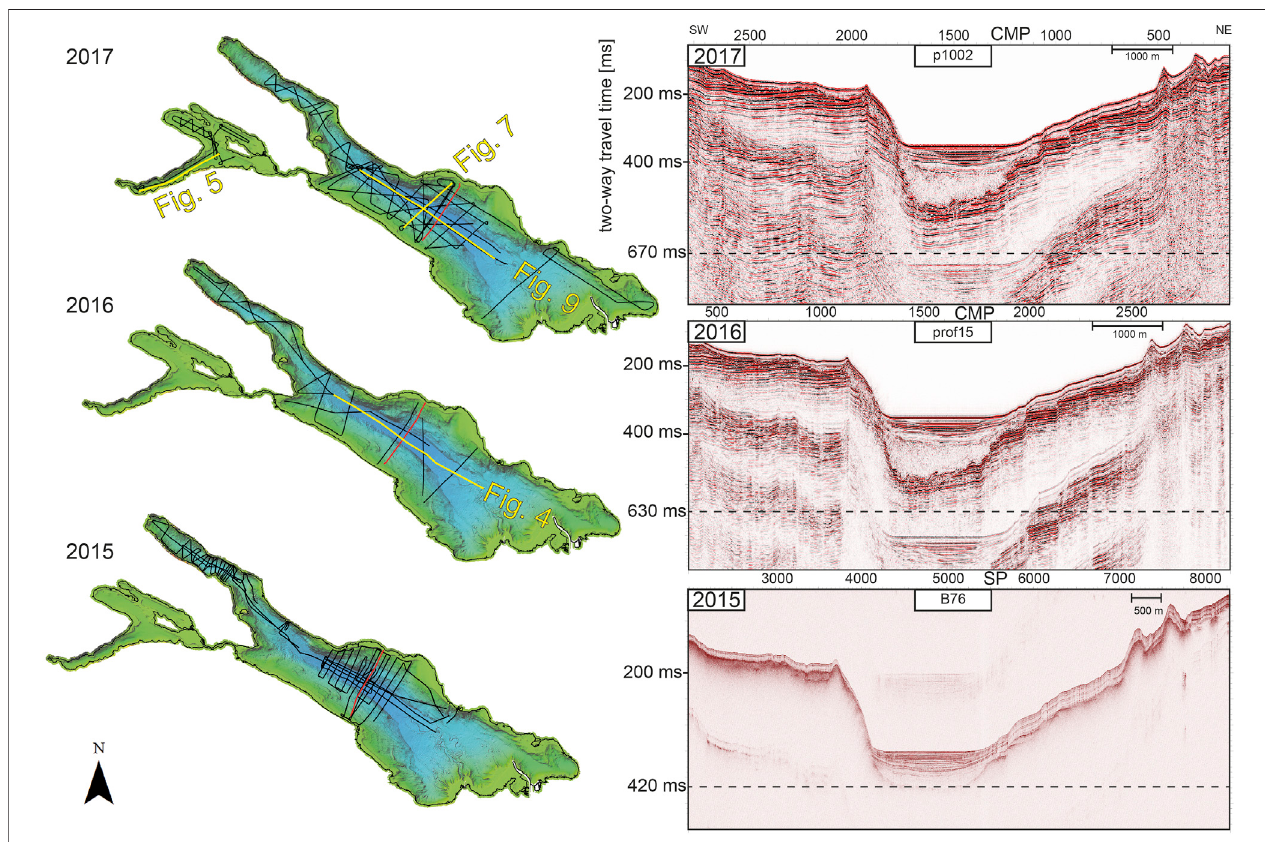
FIGURE3| left:OverviewofdifferentseismicvintagessuperimposedonbathymetryofLakeConstance.2016and2017aremulti-channelre fl ectionseismicsurvey sections; 2015 shows 3.5 kHz single channel pinger lines (Schwestermann, 2016). Right: Maximum signal penetration depth (in milliseconds) for all three seismic vintages in the main basin of Lake Constance. Location of shown sections is marked in red (left). CMP: common mid-point, SP, shot